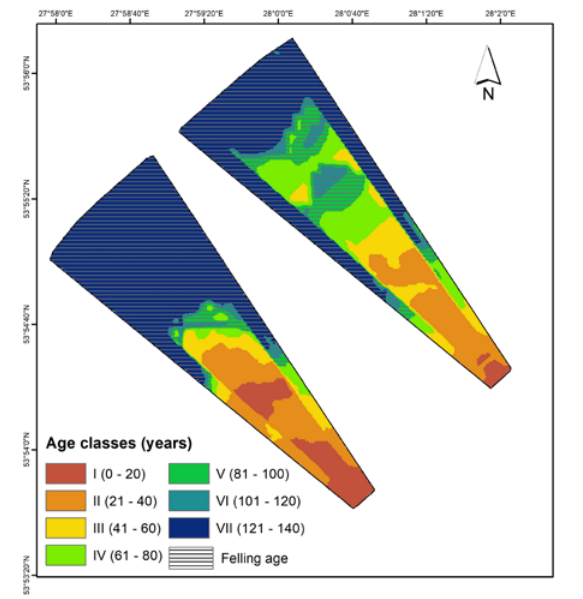
Figure 9. The pine forest age classes